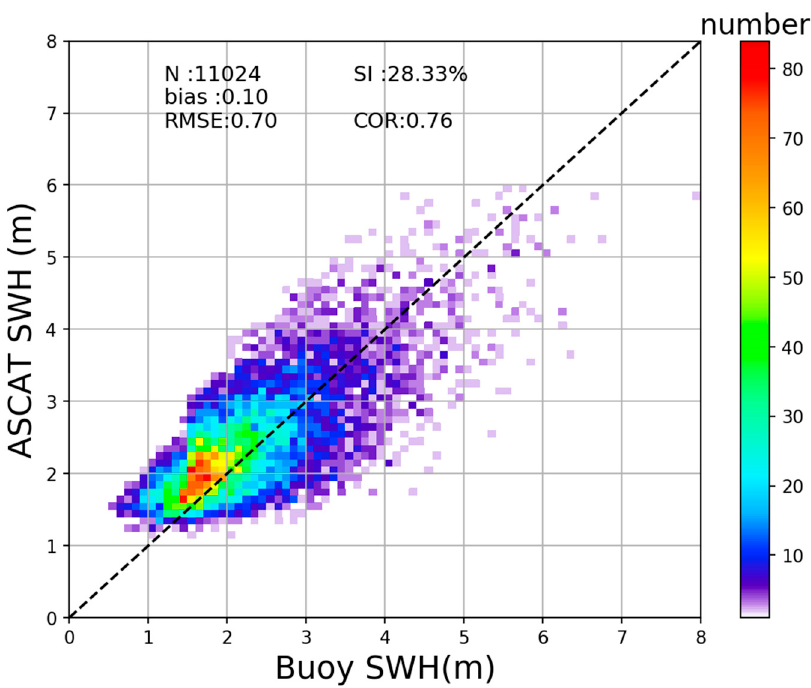
Figure 7. ASCAT SWH deeply learned estimates versus buoy measurements.